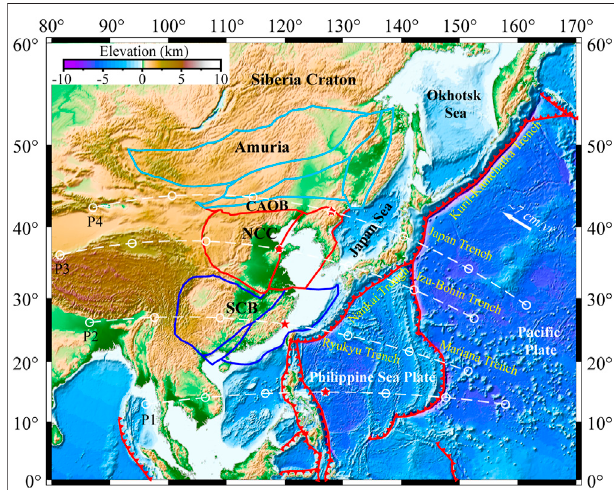
FIGURE 1 | Major tectonic settings of Eastern Asia. The blue, red and cyanlinesdenotetheshapesofSouthChinaBlock(SCB),NorthChinaCraton (NCC) and Amuria Block, respectively. The red lines with triangles denote the subduction zones. The white dashed lines denote locations of the vertical cross-sections P1-P4 shown in Figure 2 . The start, center (red star) and end coordinates with a great circle distance of 10 o for each pro fi le are marked (white circle) on each